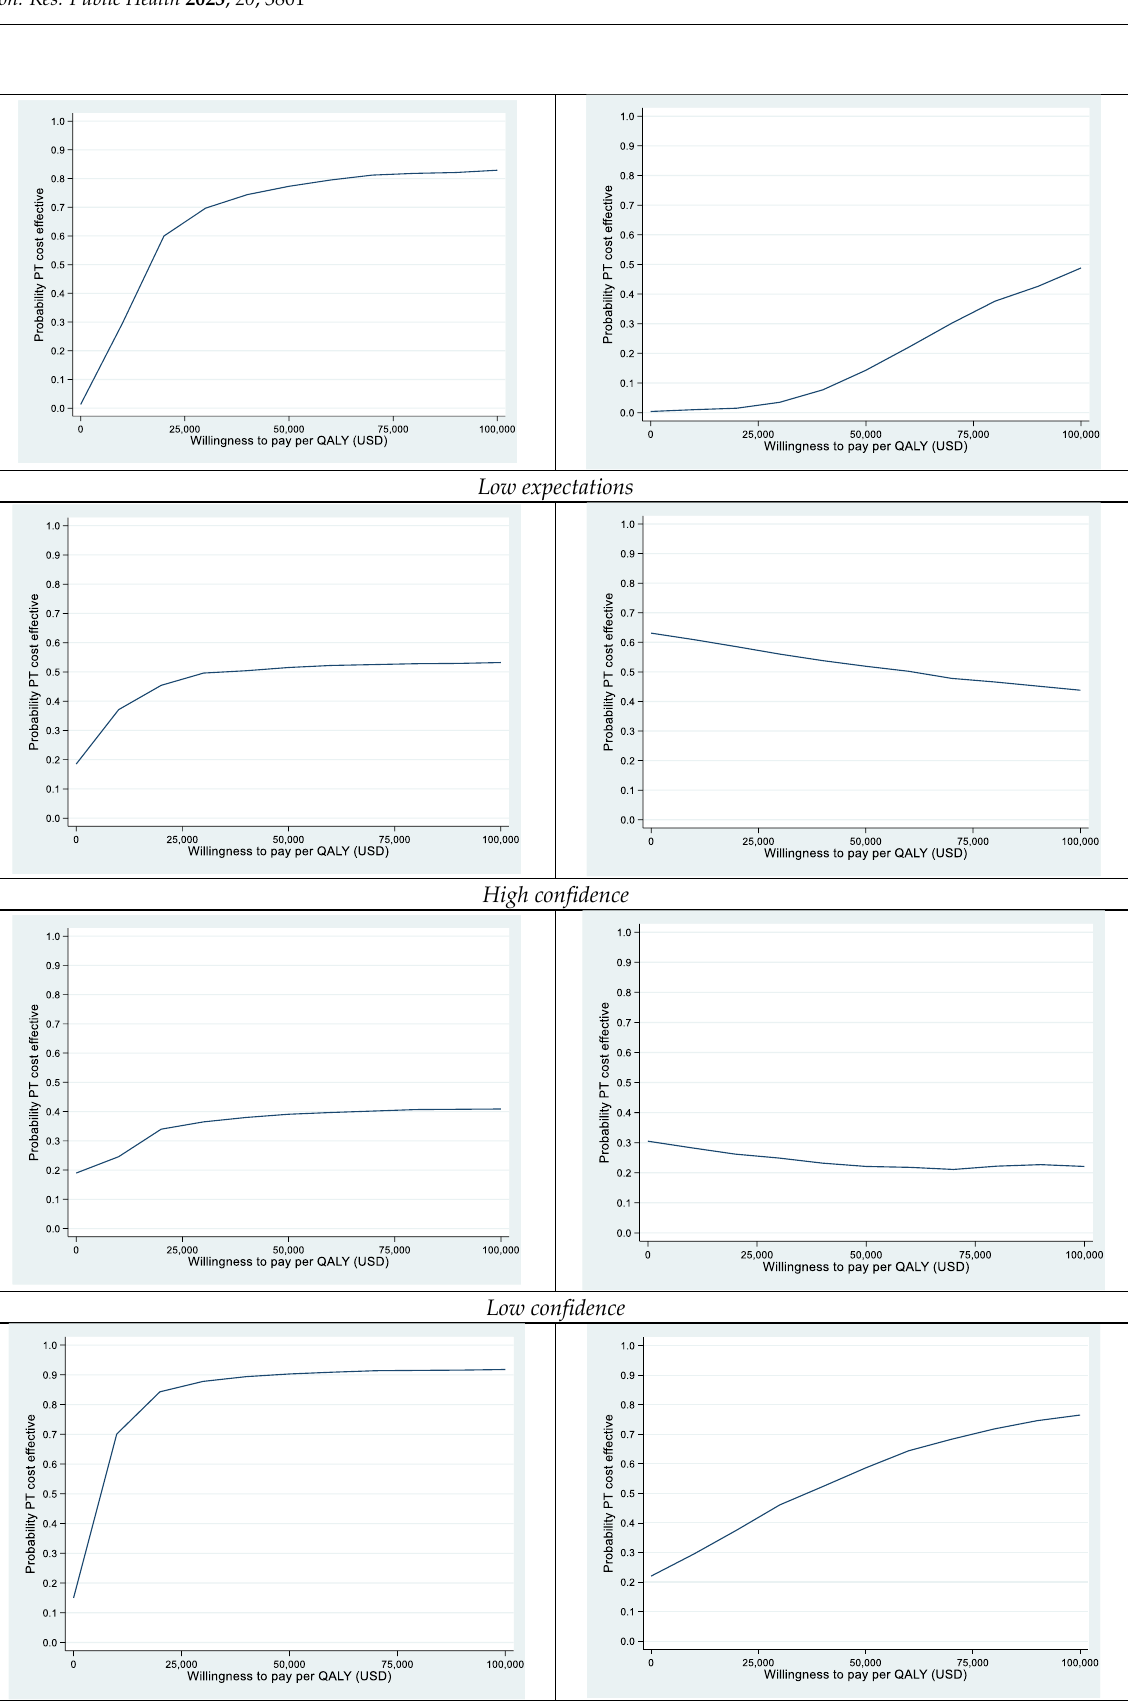
Figure 1. Cost-effectiveness acceptability curves for ( A ) all participants and ( B ) subgroups based on mediating factors.